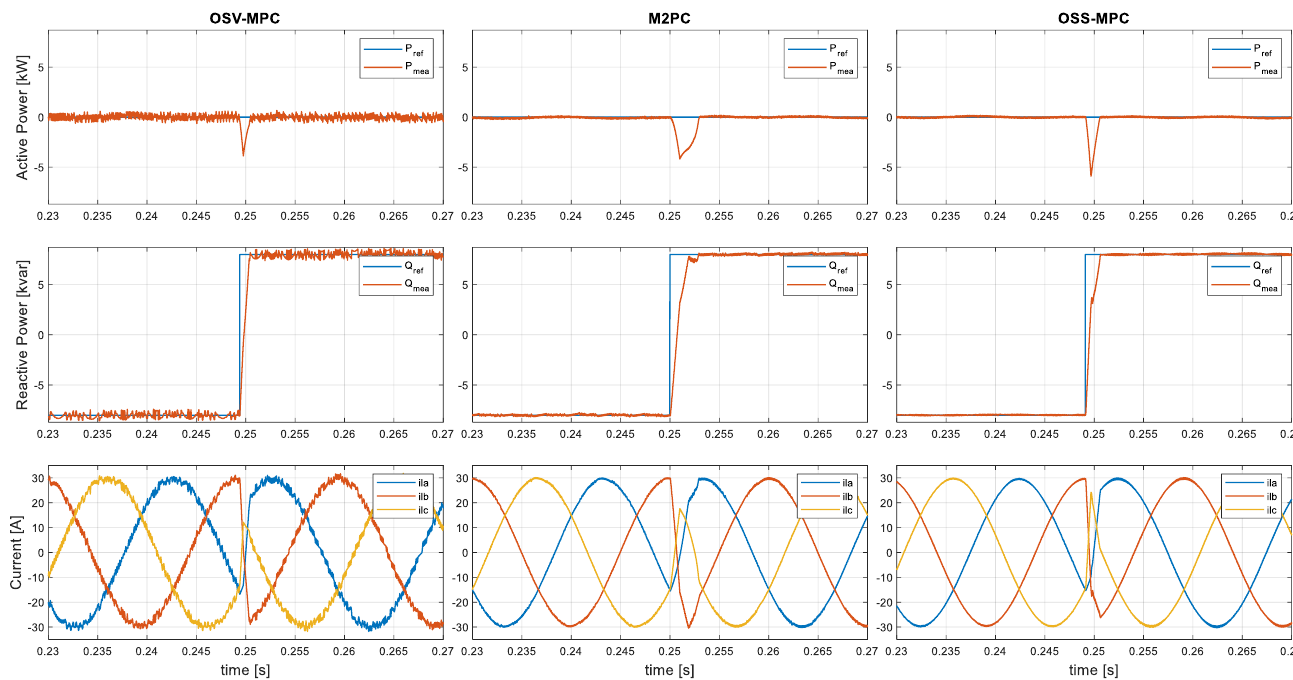
Figure 20. Transient response for active power step P ∗ = − 8 kW to P ∗ = +8 kW for each FCS-MPC technique.